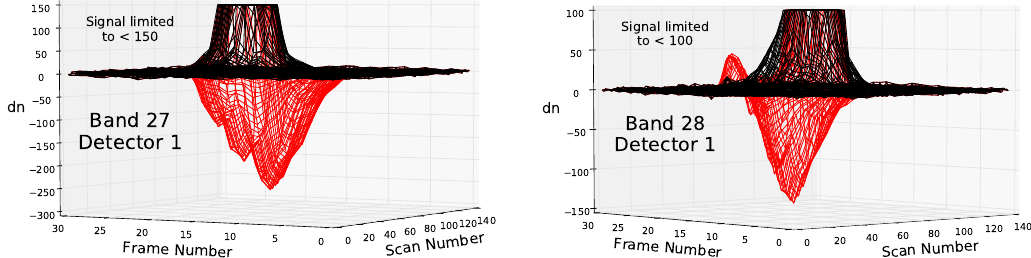
Figure 3. Example corrections for lunar data from 4 August 2015. The red data is before correction and the black data is after